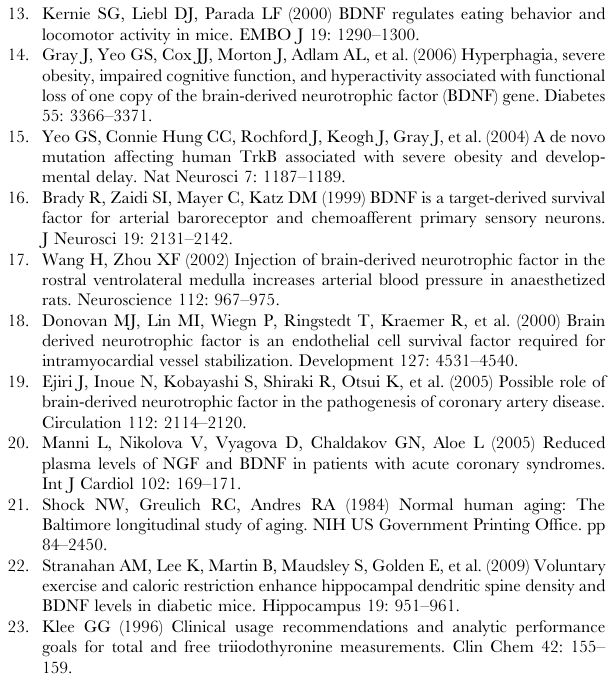
Table S1 Linear Regression analysis of plasma BDNF and metabolic and cardiovascular dysfunction risk factors, measured in males and females in the BLSA